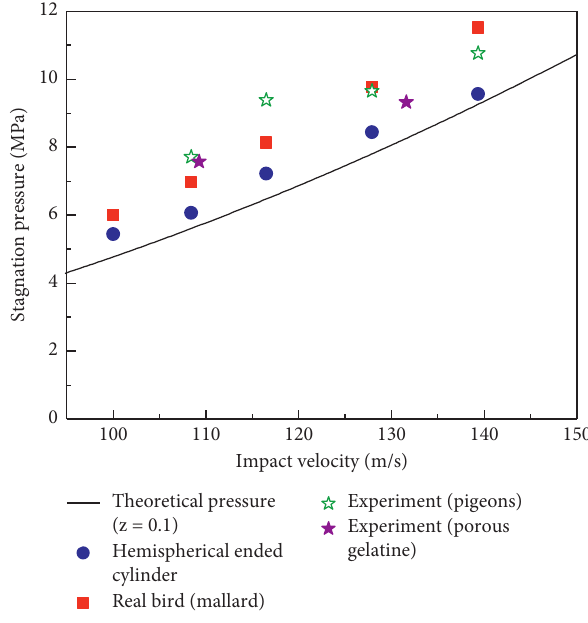
Figure 9: Calibration of stagnation